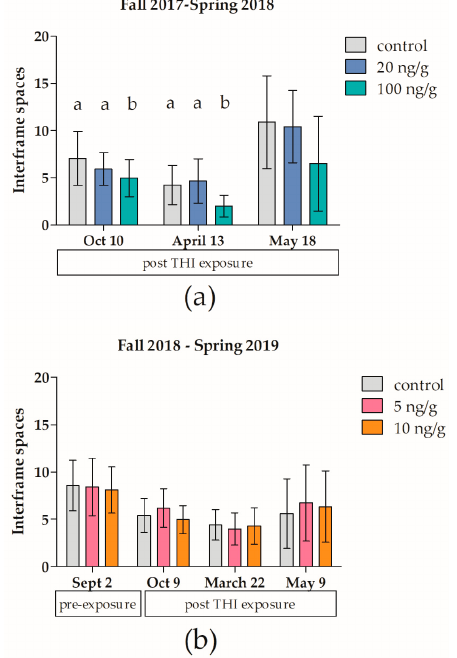
Figure 3. Chronic high-dose (100 ng/g) thiamethoxam significantly decreases cluster size of Apis mellifera colonies in the field. Honey bee colonies were exposed to thiamethoxam (THI) over winter in field trial 1 (2017–2018) ( a ) or field trial 2 (2018–2019) ( b ), and adult bee cluster size of the colonies